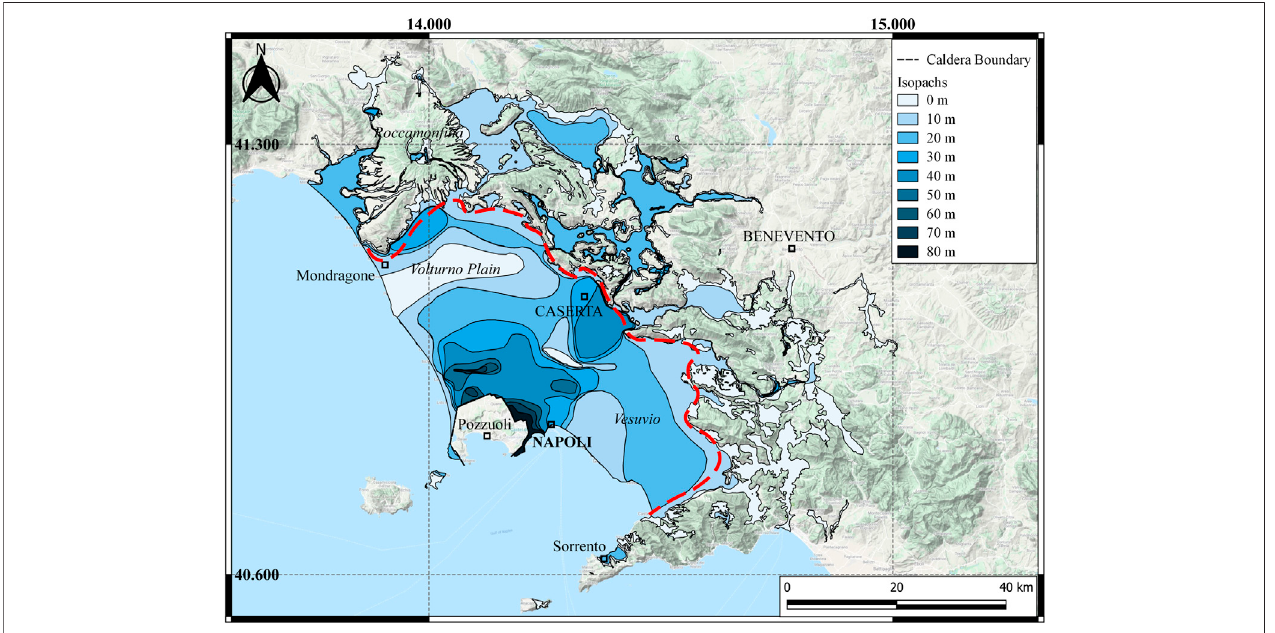
FIGURE 5 | Isopach map of the preserved extra-caldera deposits of the Campanian Ignimbrite. This map refers only to the ignimbrite deposits; it excludes the Plinian fallout and the co-ignimbrite ash. The different colors for each isopach are reported in the map key. The red dashed line divides the proximal and the distal area.